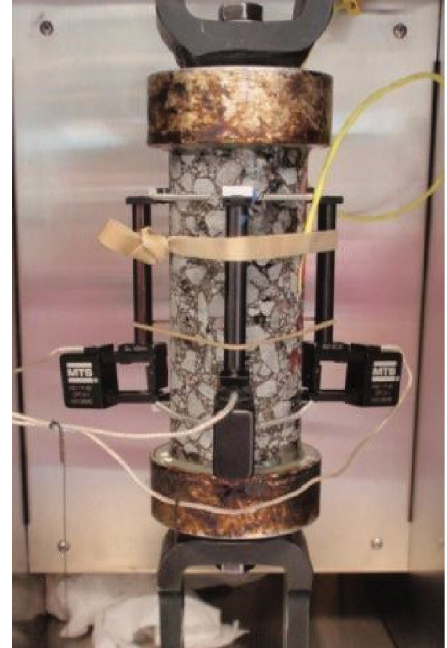
Figure 4. Instrumented sample in temperature